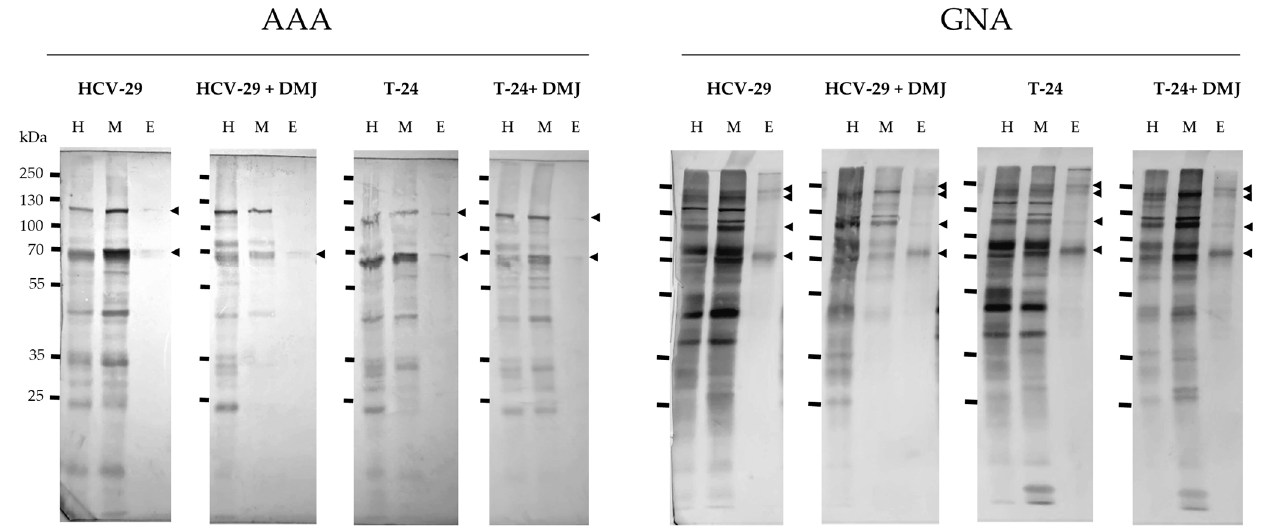
Figure 7. Detection of glycoproteins having fucose (AAA-positive) and mannose (GNA-positive) residues. Results of lectin blotting with AAA and GNA are shown in the Figure. Controls with the competitive sugars are shown in Supplementary Data (Figure S3). The major specific bands were indicated on the right with arrowheads. H, the whole cell protein extract; M, the membrane fraction; E, the ectosomal fraction.